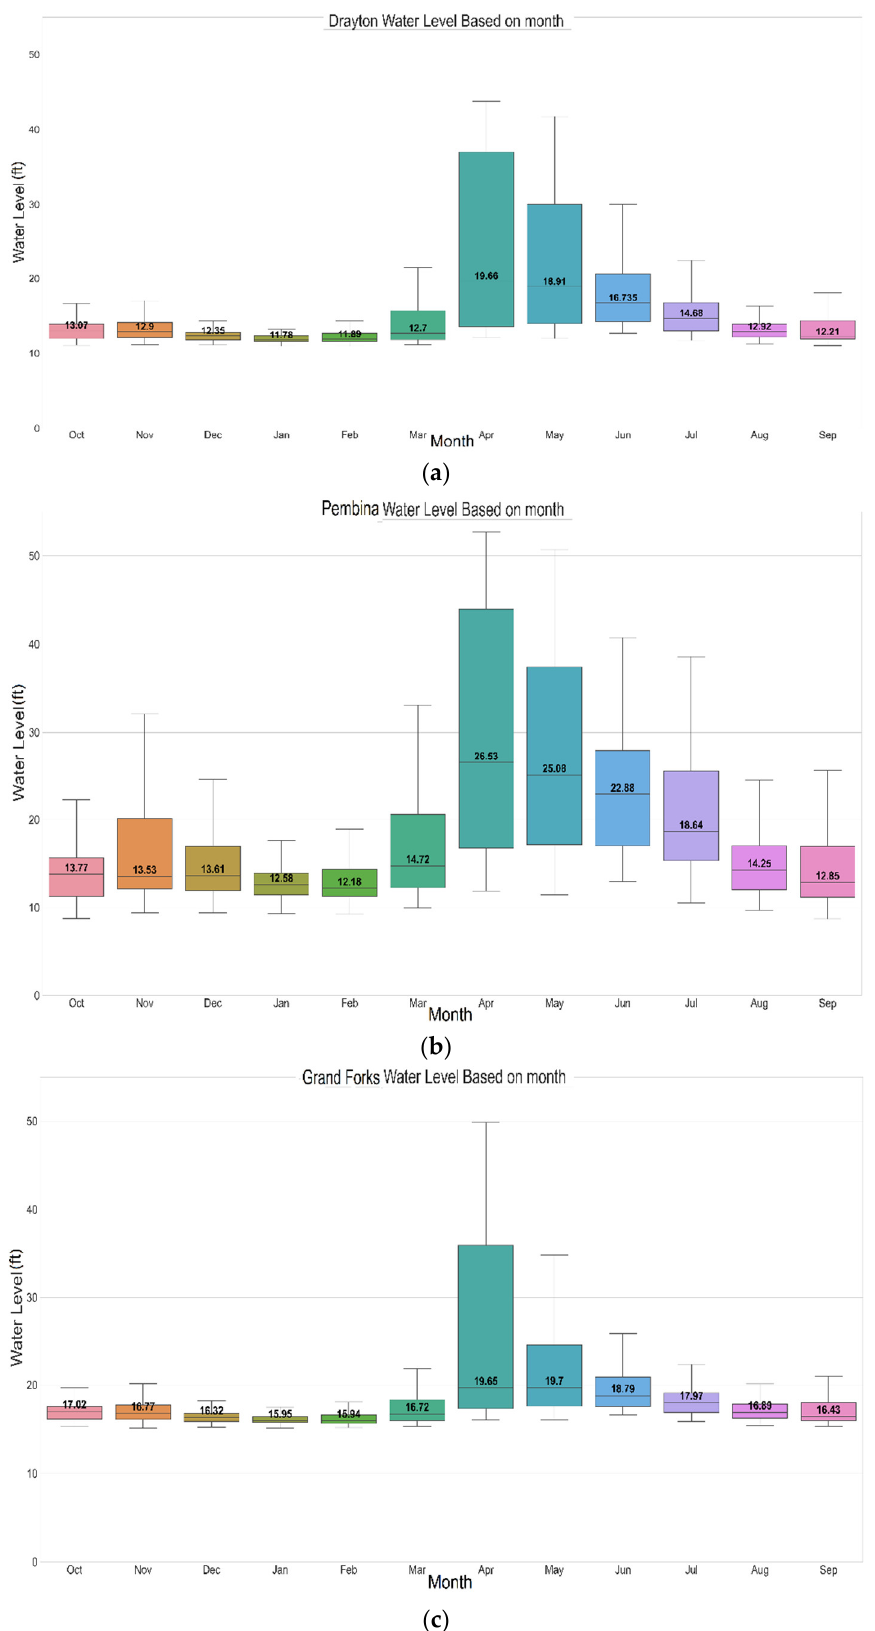
Figure 2. Monthly water level at three hydrology stations of Red River of the North: ( a ) Pembina, ( b ) Drayton, and ( c ) Grand Forks stations.